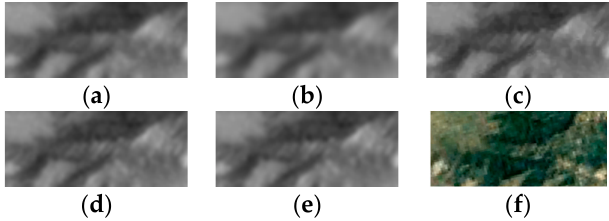
Figure 8. The regions denoted by the rectangles in Figure 7. ( a ) The bicubic upsampled reference image; ( b ) the added image after registration; the HR images reconstructed by ( c ) the proposed method, ( d ) IBP and ( e ) Farsiu’s algorithm; ( f ) the image chipped from Google Earth. The Google Earth image is rotated to be compared with the Gaofen-4 images without ortho-rectification.